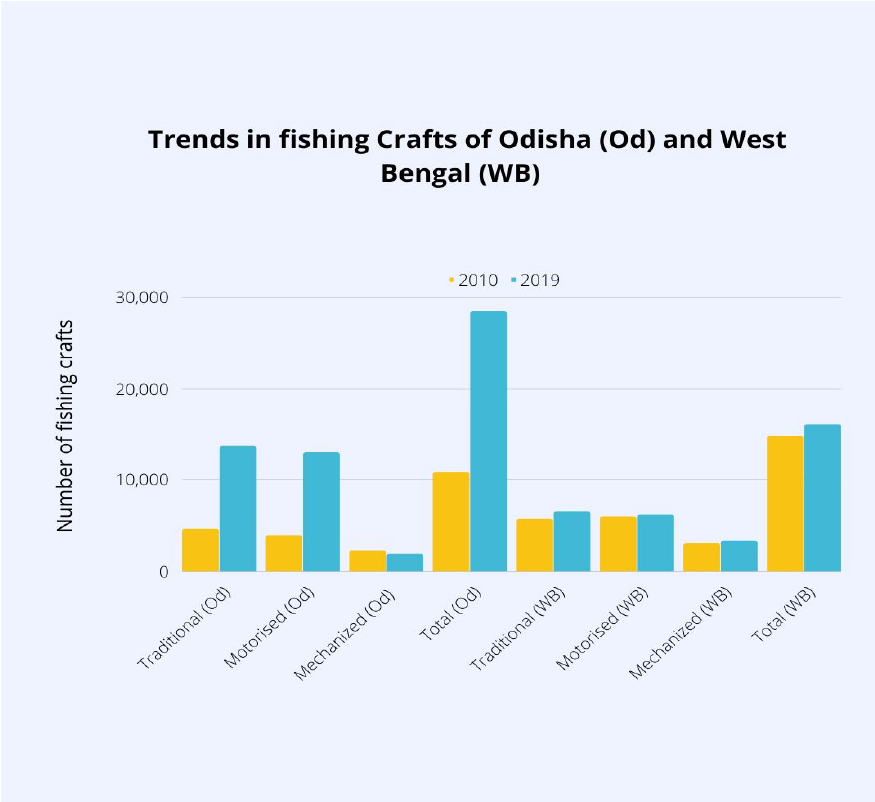
Figure 5. Analysis of fishing crafts (traditional, motorized, and mechanized crafts) in Odisha and West Bengal compared between the years 2010 and 2019 scenario. (Source: GoI [5] and GoI [7]).